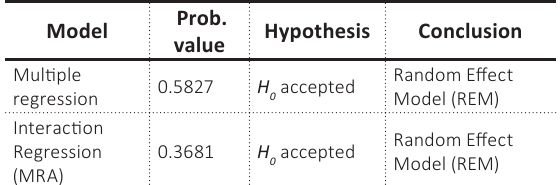
Table 3. Hausman test